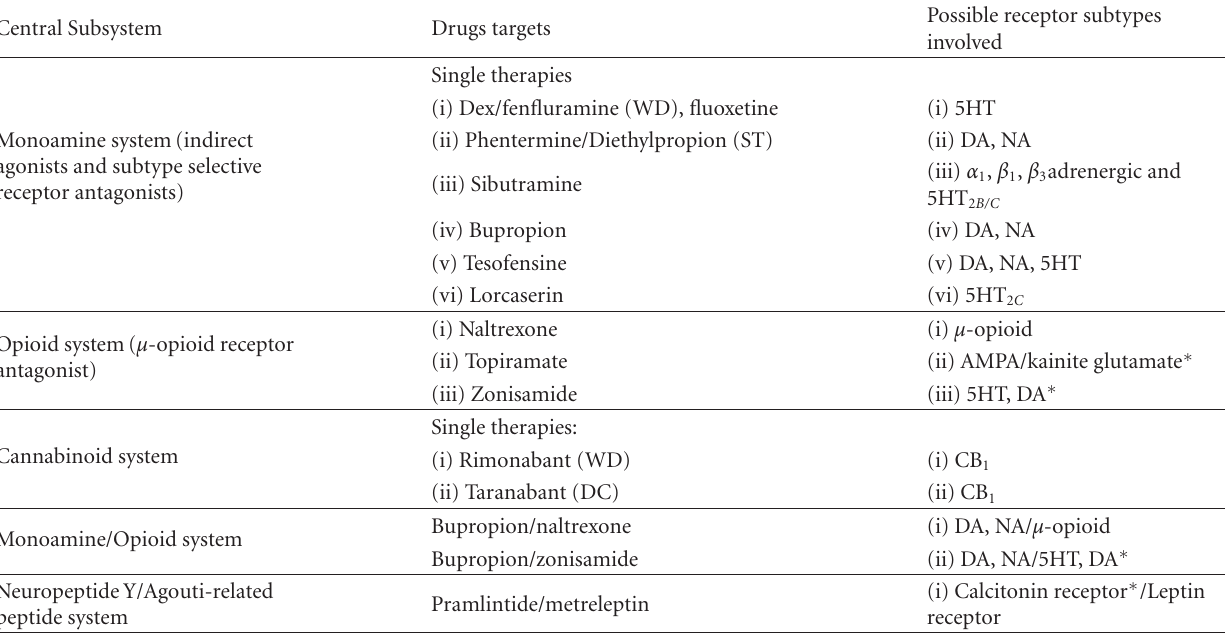
Table 2: Central mechanisms of action of anti-obesity